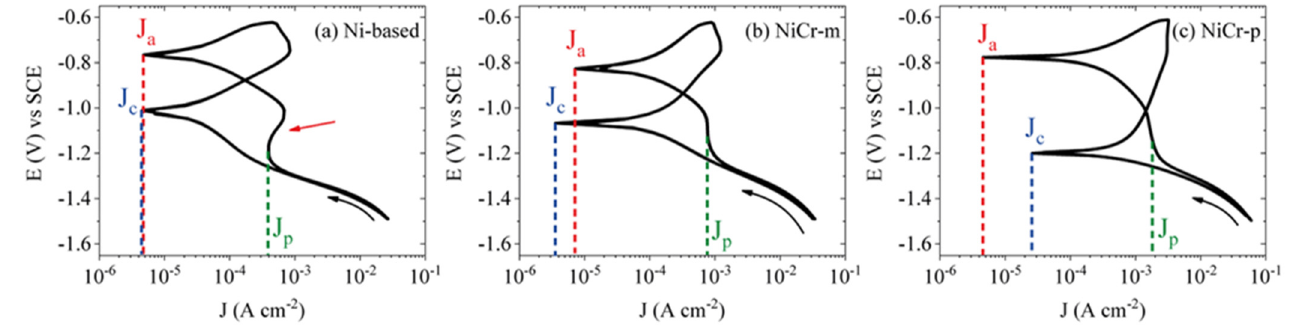
Figure 8. E vs. J curves of the electrodes at the 100th cycle of ( a ) Ni-based, ( b ) NiCr-m and ( c ) NiCr-p. Table 3. Activation energy values are calculated at